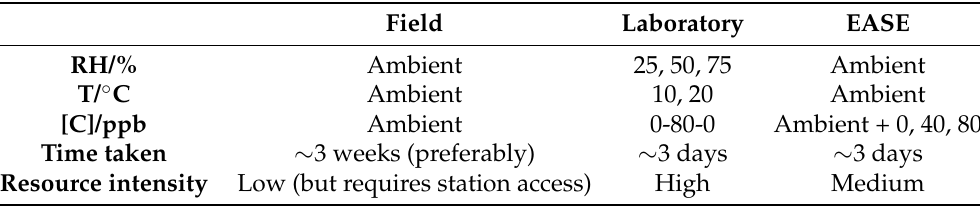
Table 2. Calibration method overview. A schematic showing the time-series for the different methods is included in Figure